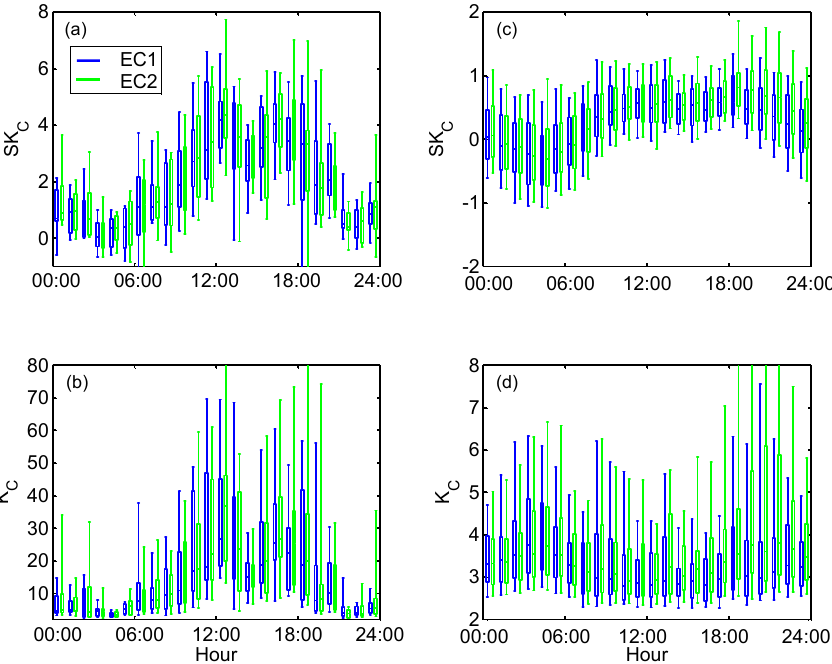
Figure 8. Diurnal variability of skewness (SK) and kurtosis ( K ) of CO 2 for the 150–200 ◦ sector (a, b) and for the other directions (c, d) in summer (June to August). Notice the different y axes on each plot. Whiskers and boxes represent the 10th, 25th, 50th, 75th and 90th